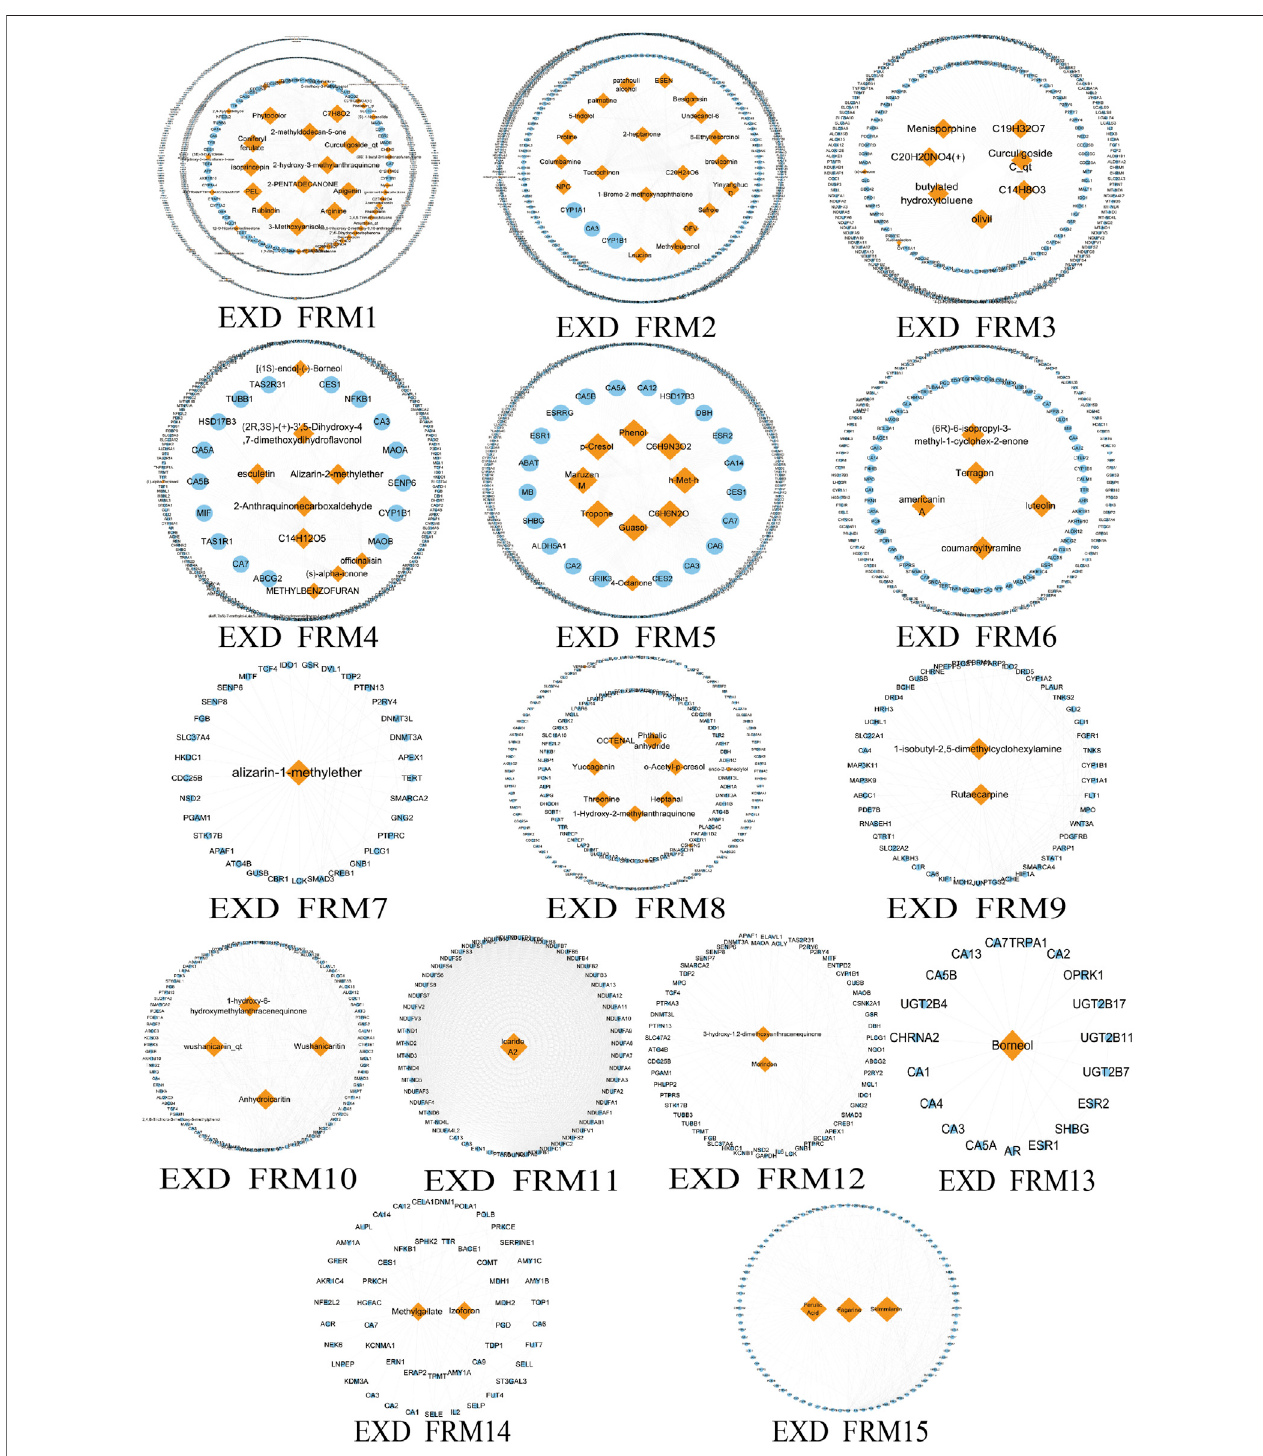
FIGURE 5 | The predicated FRMs ofthe C-T network inEXD. The orangenodes represent the componentsinEXD, and the bluenodes represent the related targets.